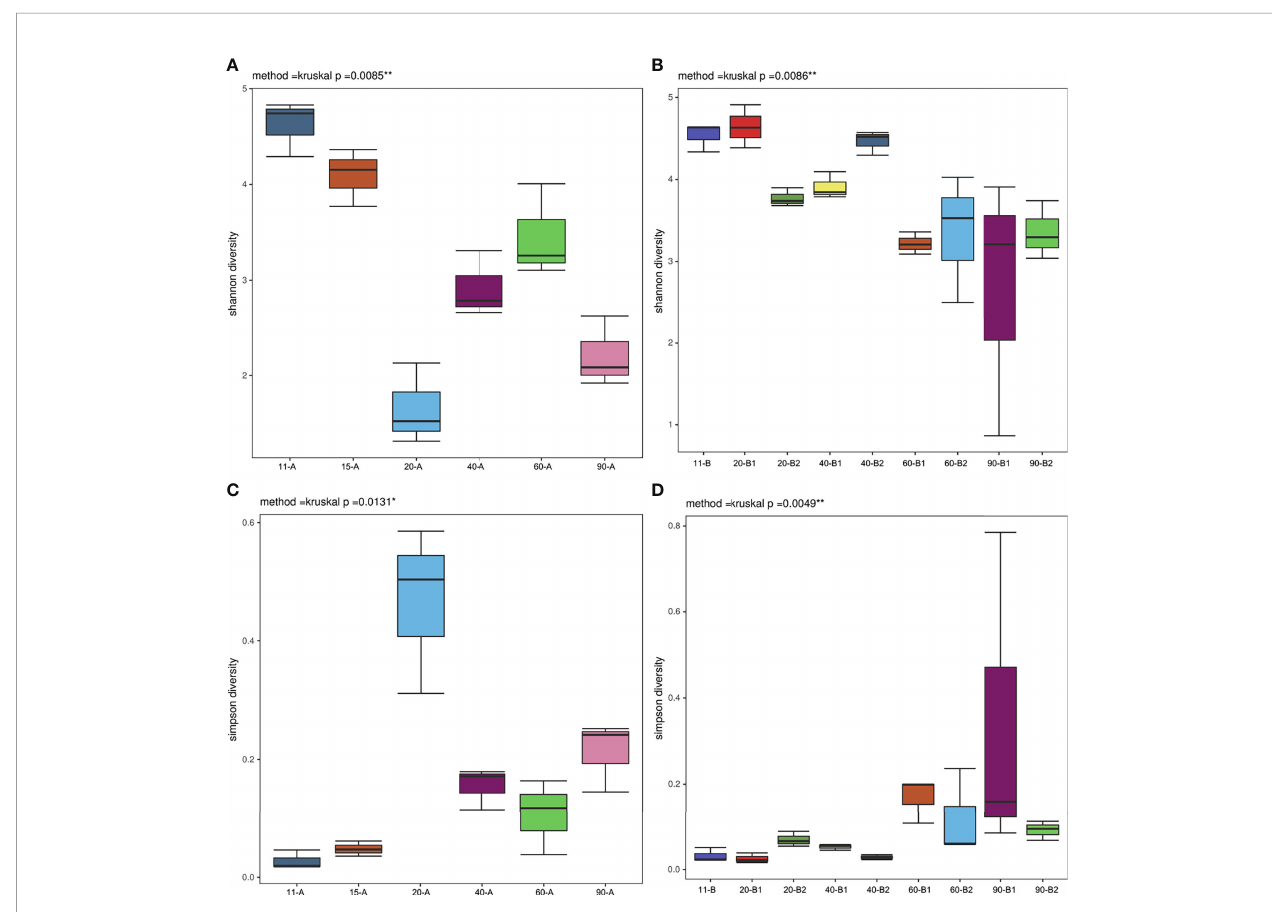
FIGURE 2 | Alpha diversity measures at the OTU level. (A) Shannon index for Experiment I (n=3), (B) Shannon index for Experiment II (n=3), (C) Simpson index for Experiment I (n=3) and (D) Simpson index for Experiment II (n=3). *p < 0.05, **p <